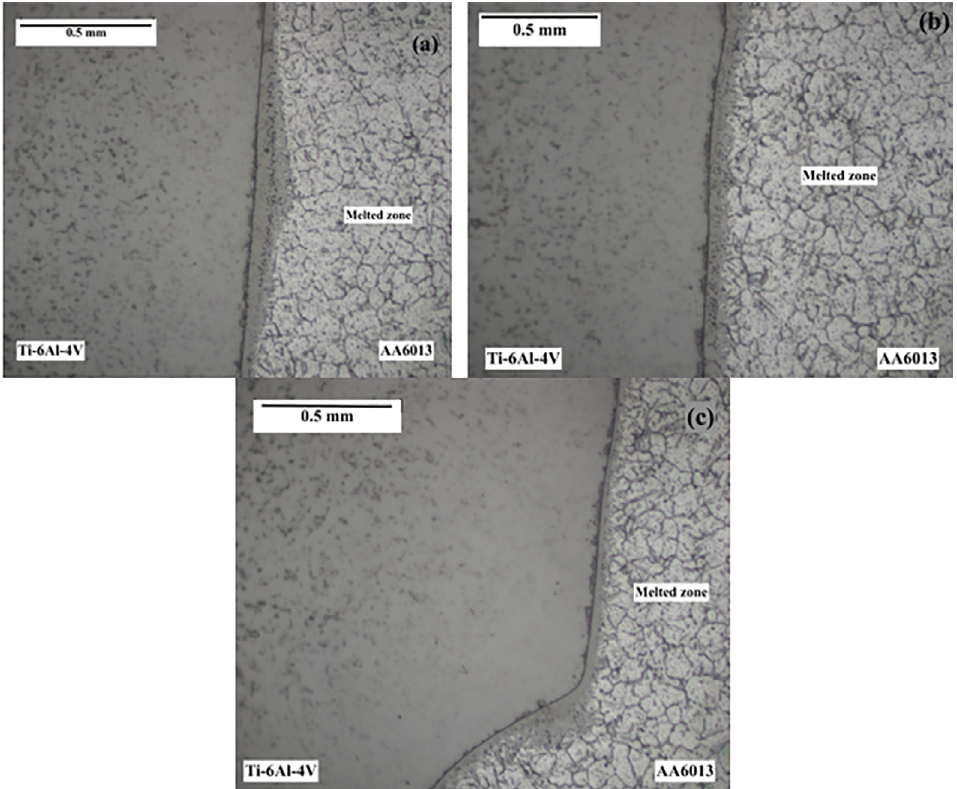
Figure 6. Magnified micrographs of the fusion zone interfacial microstructure, showing the (a) top, (b) middle, and (c) bottom region.